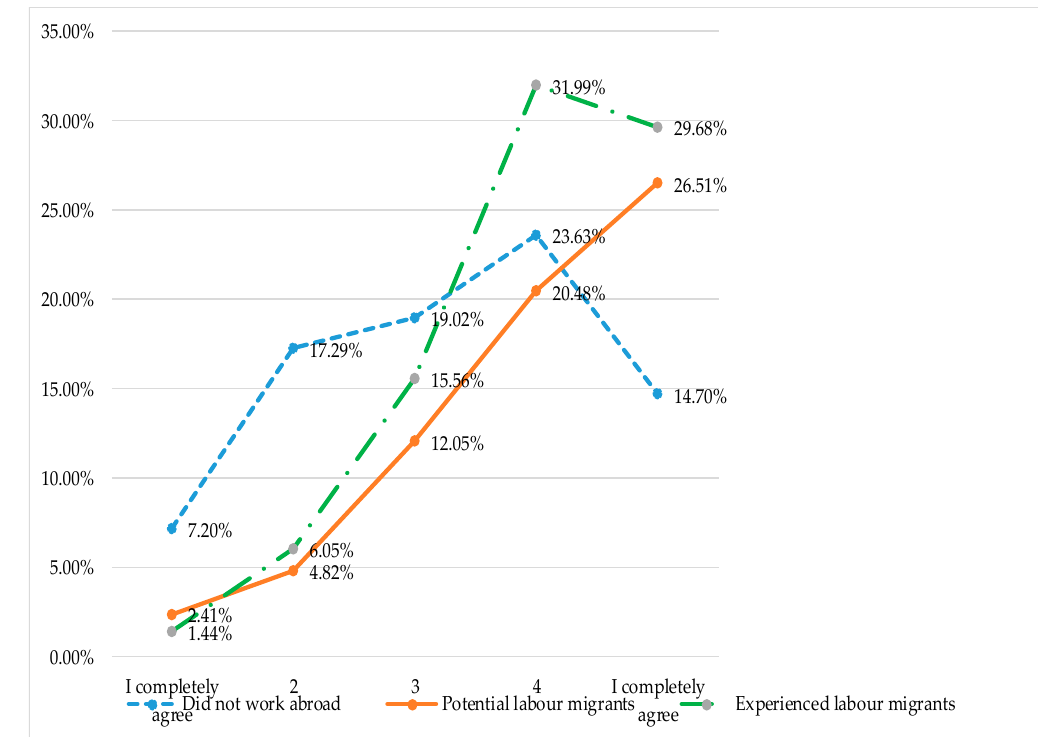
Figure 3. Distribution of responses of experienced and potential labour migrants regarding the ability to use a foreign language in their professional activity, % (author’s research data).